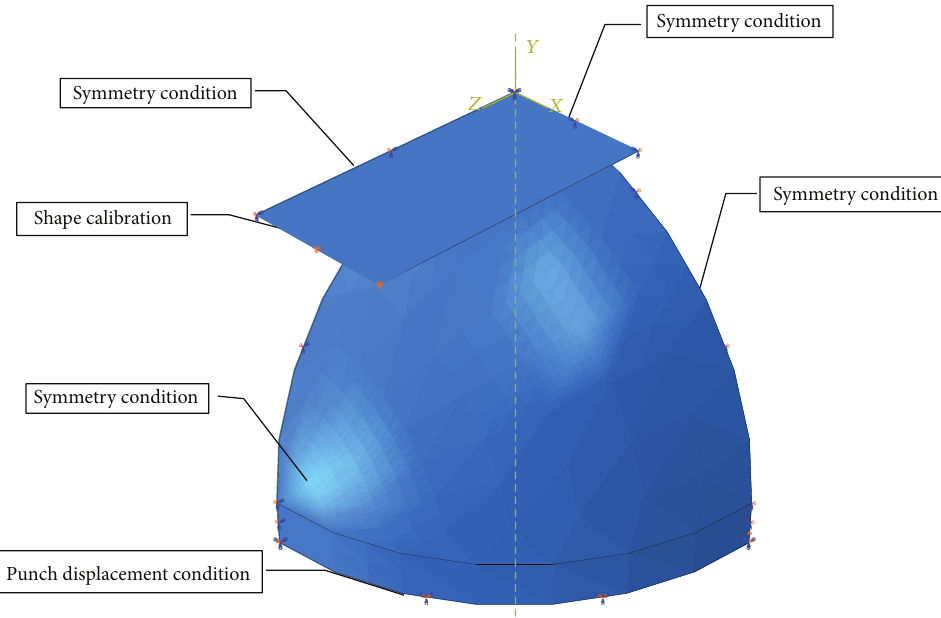
Figure 15: Boundary conditions for the Nakajima test.